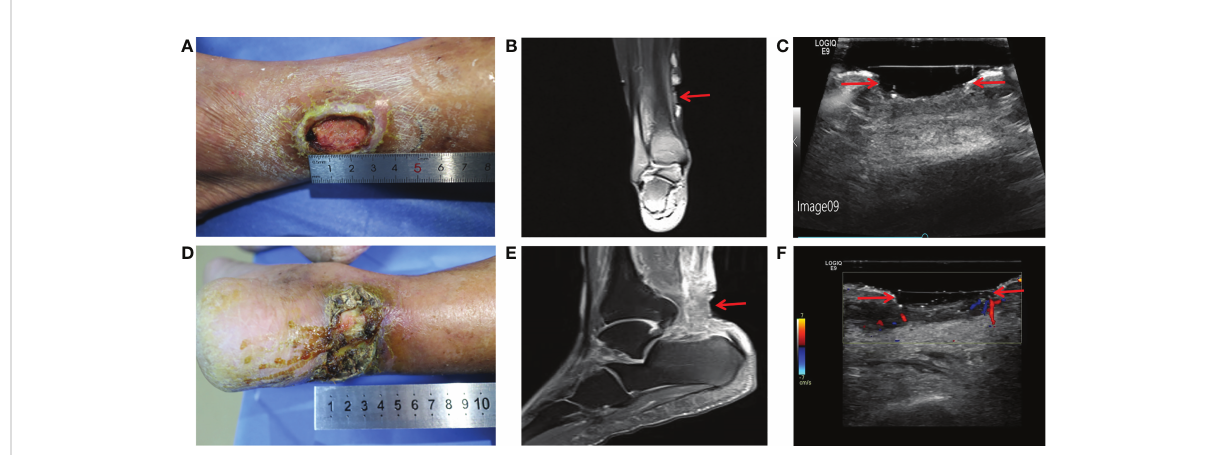
FIGURE 1 Imaging diagnosis of diabetic lower extremity ulcers before treatment for case 1 (A-C) and case 2 (D-F) . (A) Picture showed an ulcerated surface on the inner skin of the right calf, about 3.0×2.0 cm in size and 6 mm in depth; (B) MRI showed a local subcutaneous soft tissue defect at the medial margin of the right calf, with swelling in the margin and adjacent soft tissue space; (C) Gray-scale sonography showed a heterogeneous low echo area in the subcutaneous soft tissue of the medial side of the right calf; (D) Picture showed an ulcerated surface in the skin of the right heel, about 7.5 × 4.6 cm in size and 4 mm in depth, with necrosis and exudation; (E) MRI showed extensive swelling of the soft tissue and fascia in the lower part of the right calf with unclear and disordered layers; (F) CDFI showed local skin defects and discontinuity in the skin of the right heel. The blood fl ow signal in the low echo surface was not obvious, and a little blood fl ow signal could be seen in the periphery. The red arrows indicate the ulcer